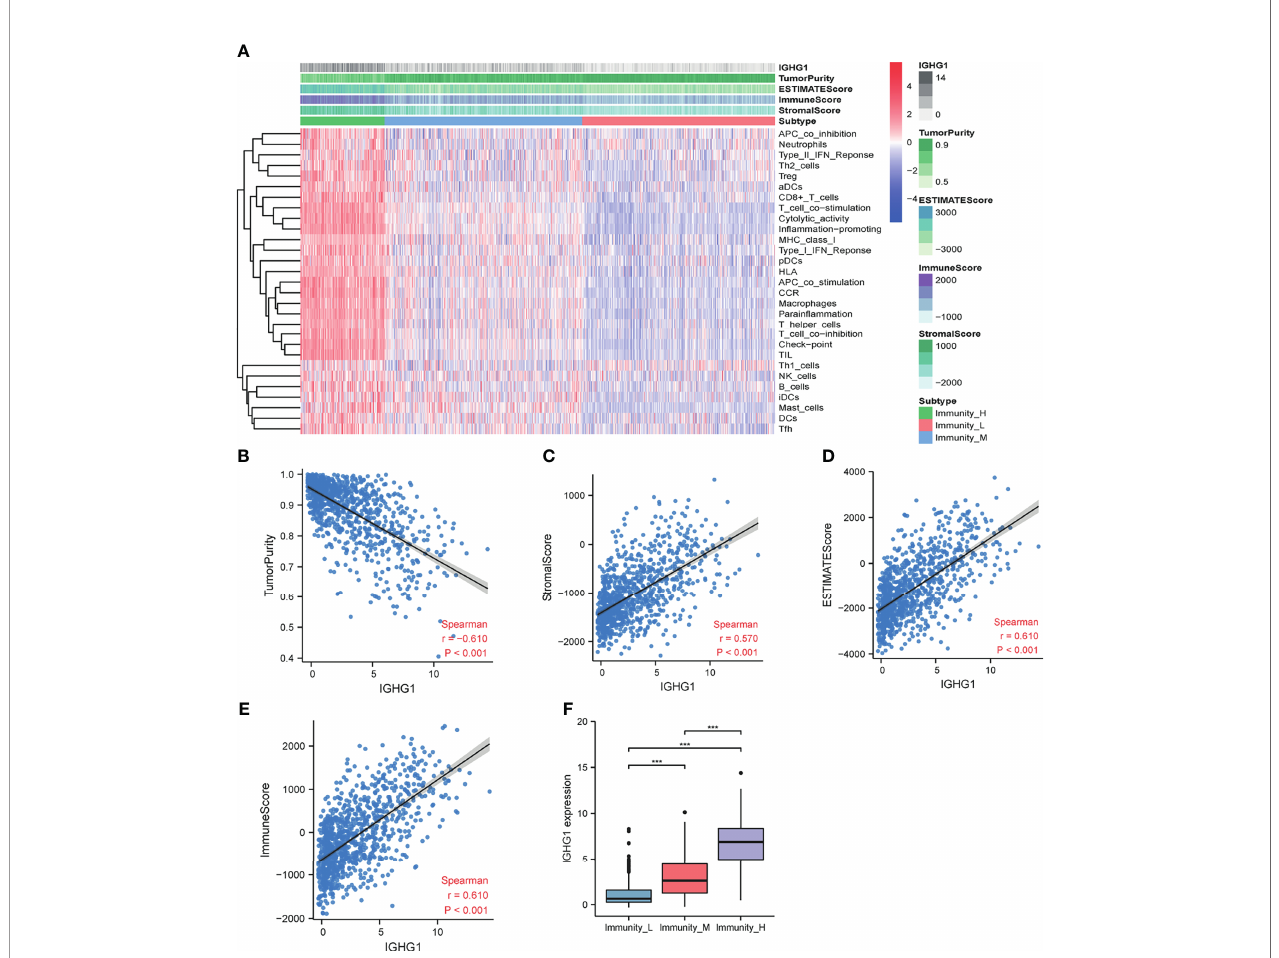
FIGURE 4 | Immune in fi ltration patterns of the low- and high- IGHG1 groups analyzed using single-sample gene set enrichment analysis (ssGSEA) methods in glioma from the Chinese Glioma Genome Atlas (CGGA) dataset. (A) Heatmap revealing the scores of immune cells in the low, medium, and high immunity groups. (B – E) Scatter plot showing the correlations between IGHG1 and tumor purity, stromal score, ESTIMATE score, and immune score. (F) A high expression of IGHG1 indicates more immune cell in fi ltration in glioma. *** represent P <